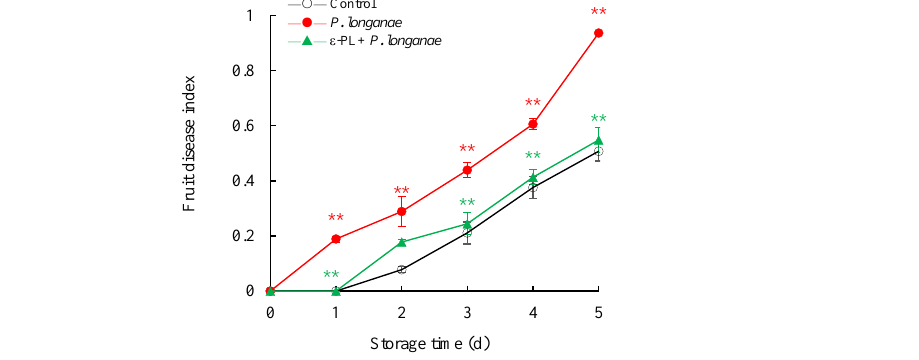
Figure 1. Effects of ε -PL treatment on fruit disease index of P. longanae -inoculated longans. Value presented in figure equals mean ± standard error of triplicate analyses, vertical bars express the standard error of mean ( n = 3). The mark ** represents the significant difference ( p < 0.05 or p < 0.01) between the P. longanae -inoculated longans and the control longans on each storage day. The mark ** represents the significant difference ( p < 0.05 or p < 0.01) between the ε -PL-treated P. longanae -inoculated longans and the P. longanae -inoculated longans on each storage day. ○ , Control; ● , P. longanae ; ▲ , ε -PL + P. longanae .